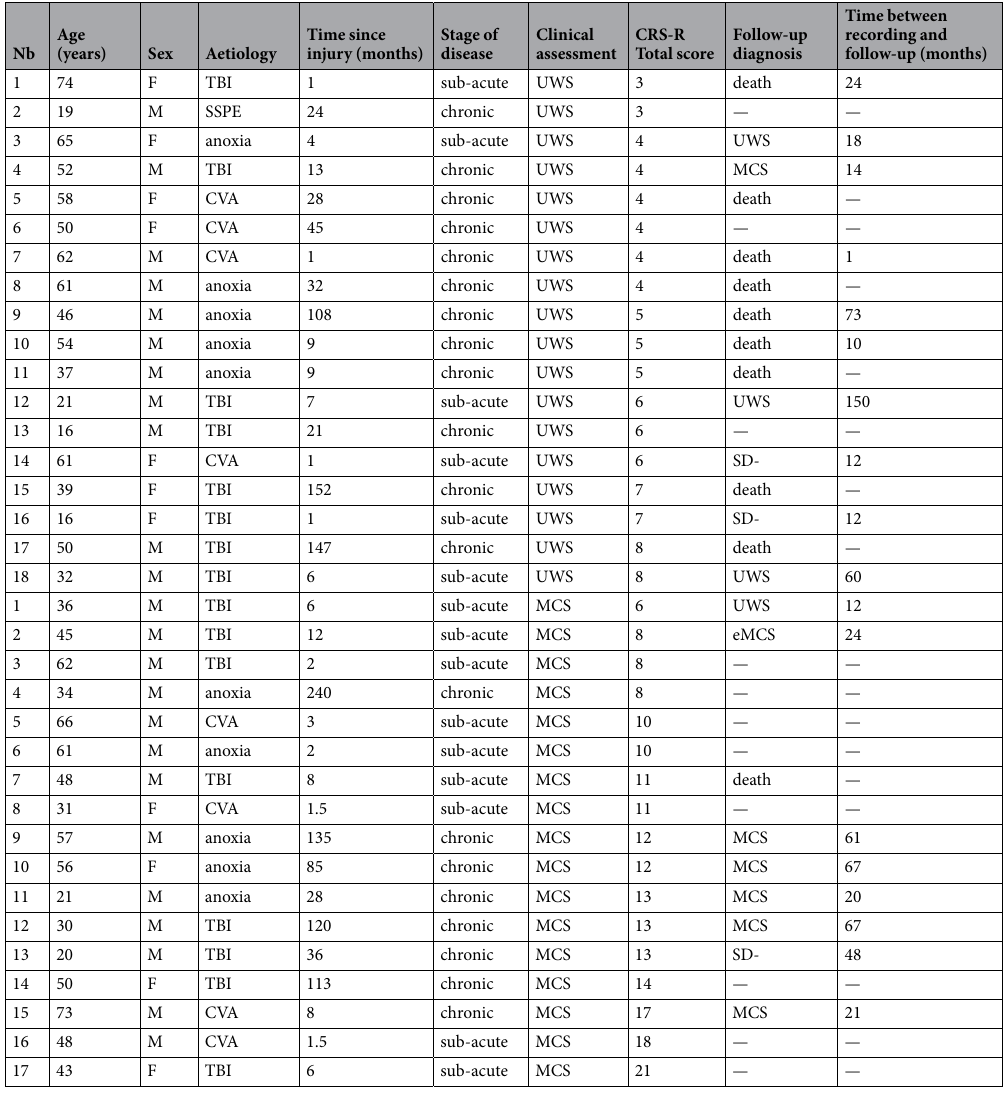
Table 1. Demographic patient data. The analyzed patient sample consisted of 18 UWS and 17 MCS subjects. Abbreviations: Sex: M = male, F = female; Aetiology: TBI = Traumatic Brain Injury, CVA-Cerebrovascular Accident, SSPE = Subacute Sclerosing Panencephalitis; Clinical assessment and follow-up diagnosis: UWS = Unresponsive Wakefulness Syndrome, SD − = lower severe disability (3 points on Extended Glasgow Outcome Scale), MCS = Minimally Conscious State, eMCS = emergence from MCS; CRC-R = Coma Recovery